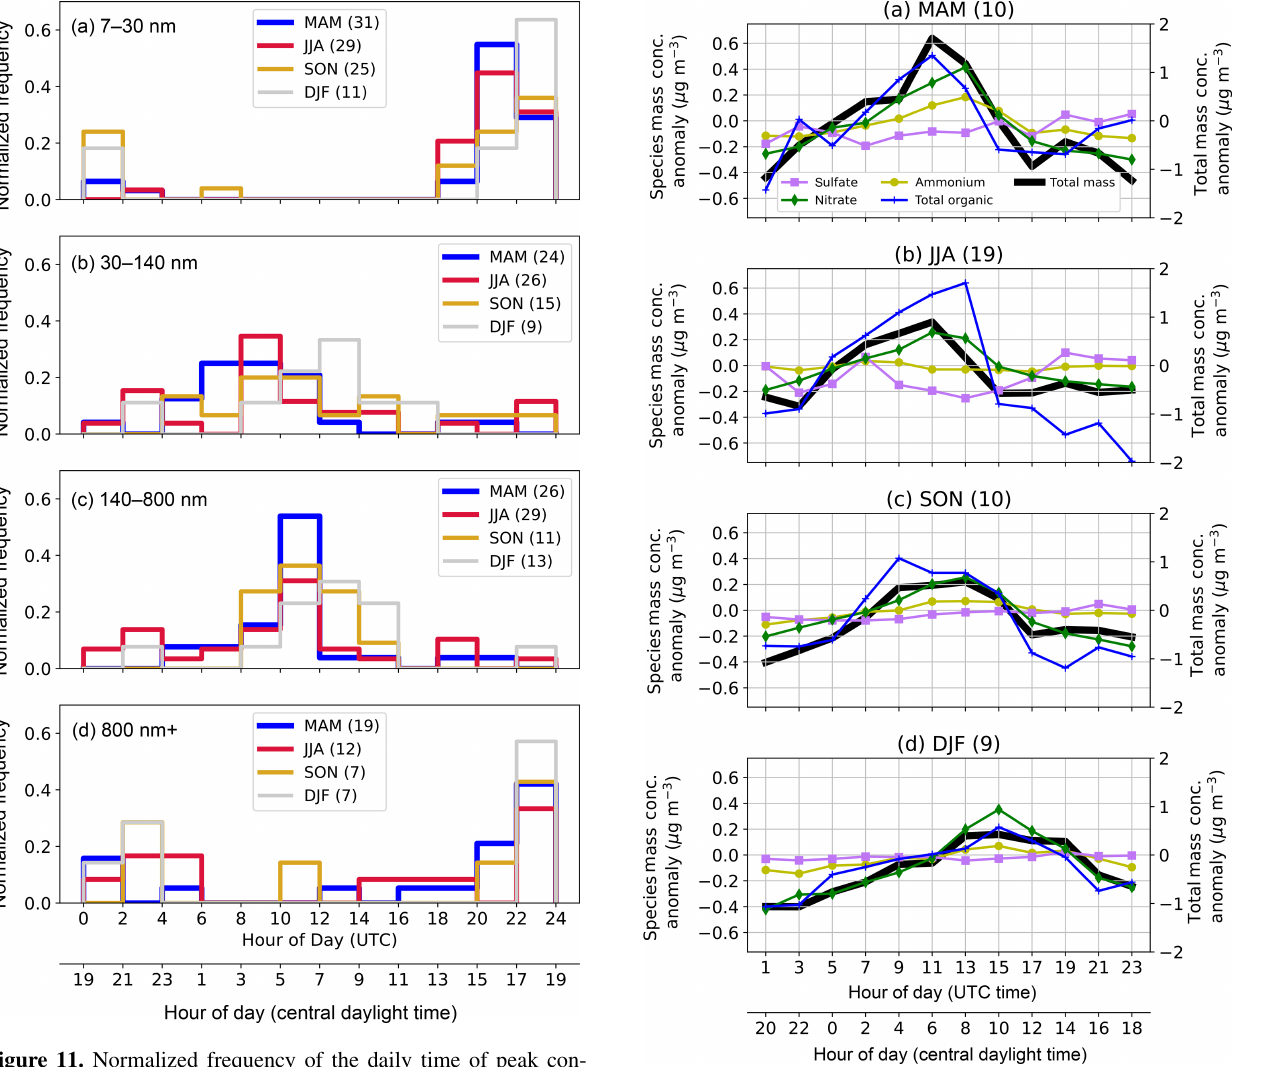
Figure 12. Diurnal cycle of aerosol mass concentration anomalies for sulfate, nitrate, ammonium, and organic aerosol species (left axes) and total mass concentrations (right axes) from the ACSM. The data were separated into seasons (a–d) and only included the weekly time periods in which the power associated with the 24h cycle in integrated volume between 140 and 800nm ( V 140 − 800nm ) was greater than that of red noise. The number of these weekly time periods is shown in the parentheses in the panel